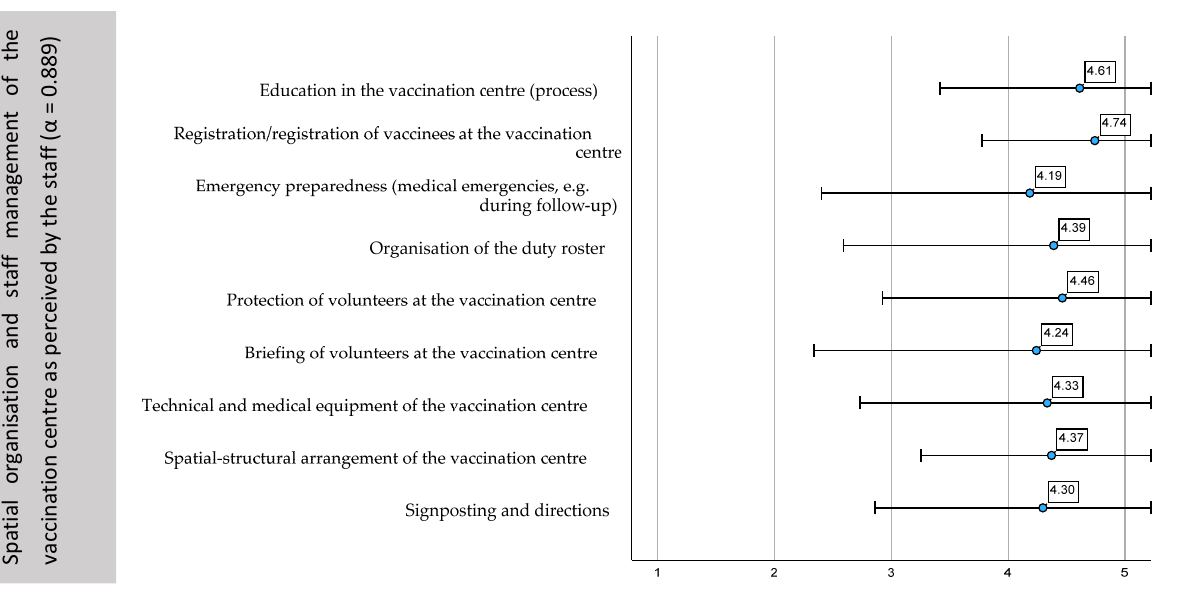
Figure 4. Satisfaction of the vaccination centre staff with the overall organisation of the centre, including spatial-structural layout. Mean values, standard deviation of the answers on the five-point Likert scale and Cronbach’s Alpha.